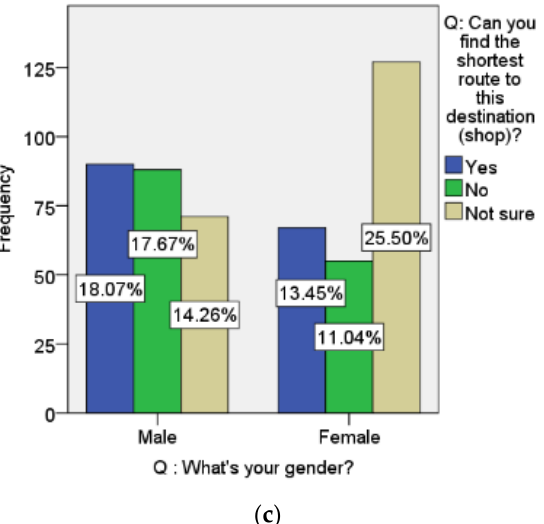
Figure 11. Frequency comparison between “Gender” and three objective data. ( a ) Shopping mall frequency; ( b ) Be familiar with the indoor map of shopping mall; ( c ) Whether the shortest path can be found.